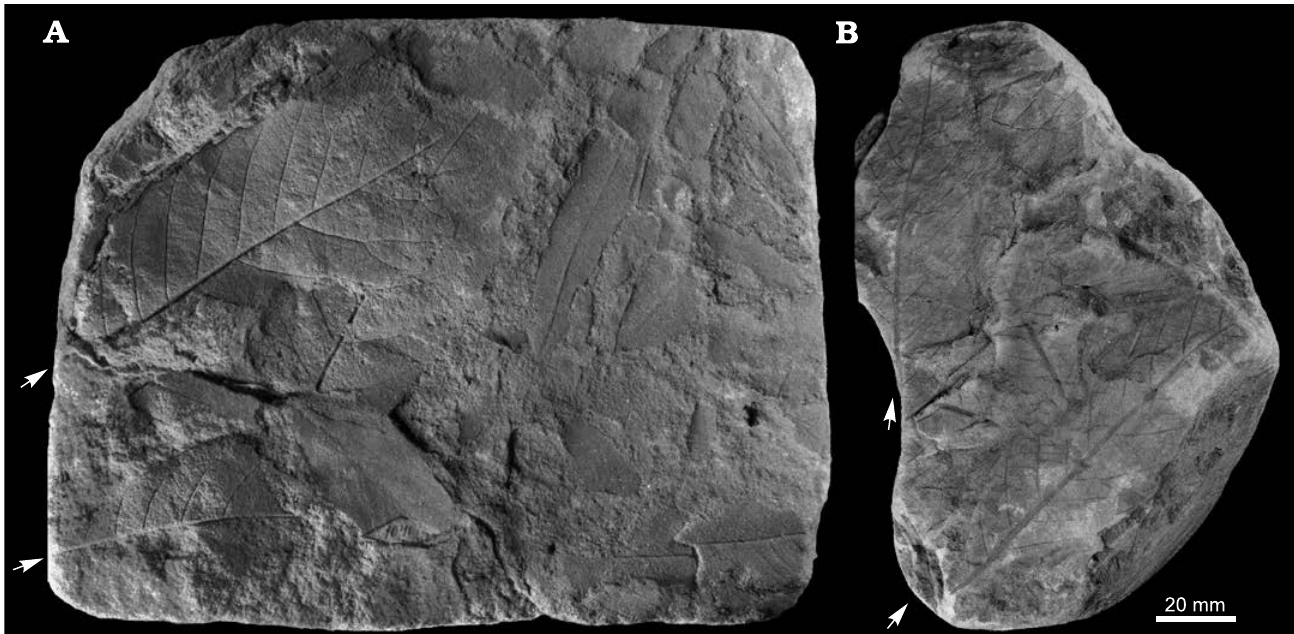
Ulina.Fig. 7. Taphonomy of the fagalean angiosperm Dryophyllum westerhausianum (Richter, 1904) Halamski and Kvaček comb. nov. from Ulina, North Sudetic Basin, Lower Silesia, Poland, Assemblage 6 (lower–middle Santonian). A . Three leaflets (arrows indicate the two largest ones possibly from the same leaf) and several incomplete or fragmentary Laurophyllum ? sp. MB.Pb.2008/347. B . Four fragmentarily preserved leaflets (arrows indicate the two largest ones possibly belonging to the same leaf) MGUWr